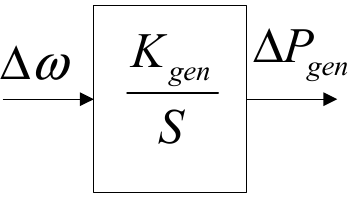
Figure 4. Model structure of frequency regulator.